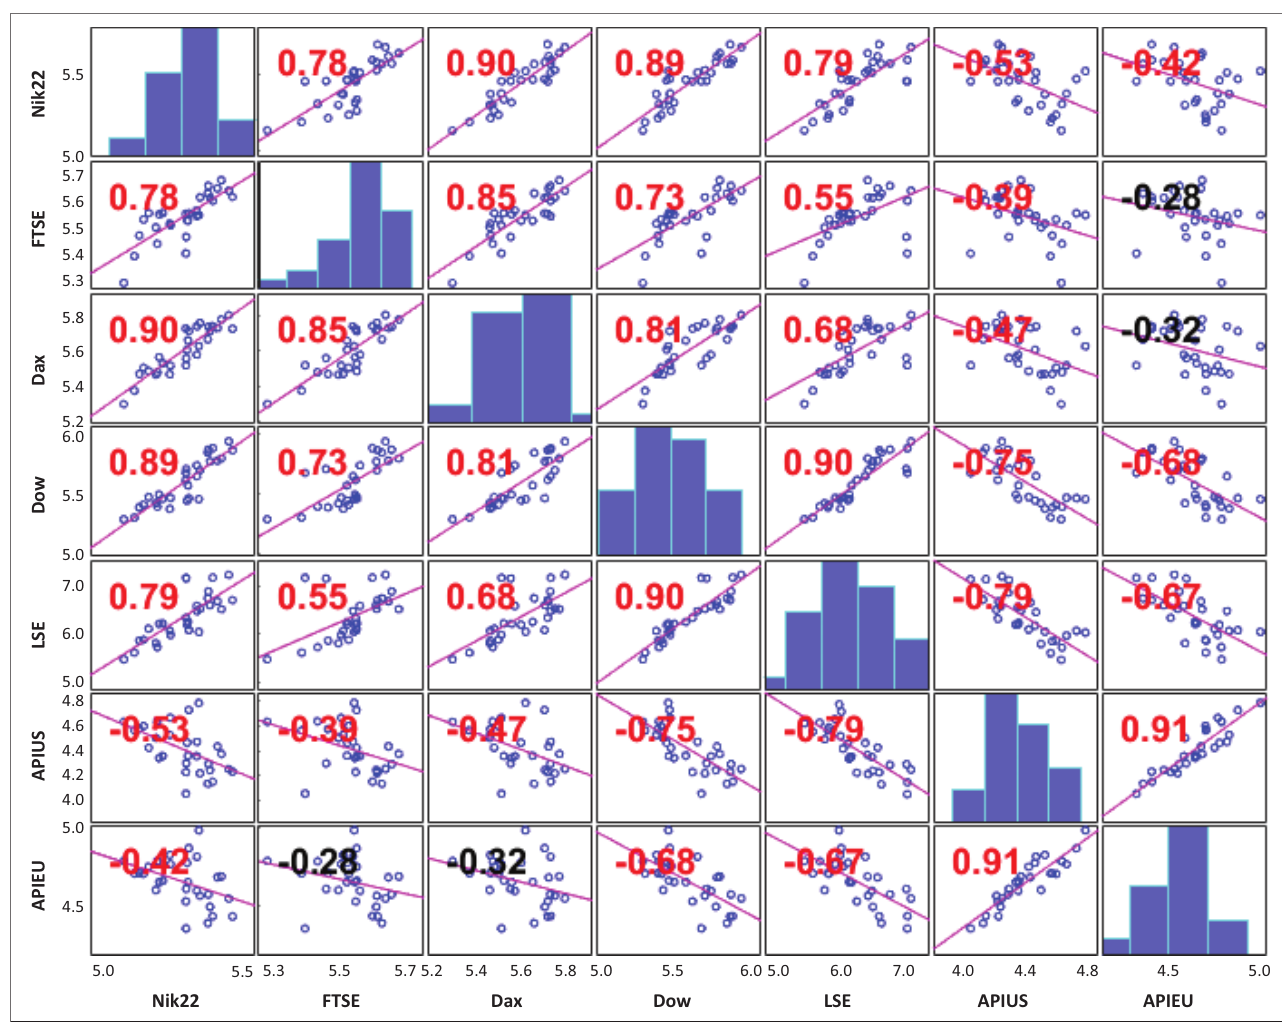
FIGURE 8: Correlation matrix examining the relationship between the markets and the Global Art Price Index using quarterly data from 1998 to